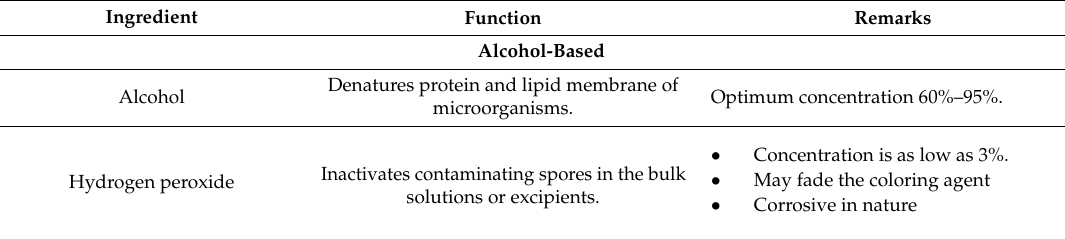
Table 4. Mechanism of action of alcohols and non-alcohol